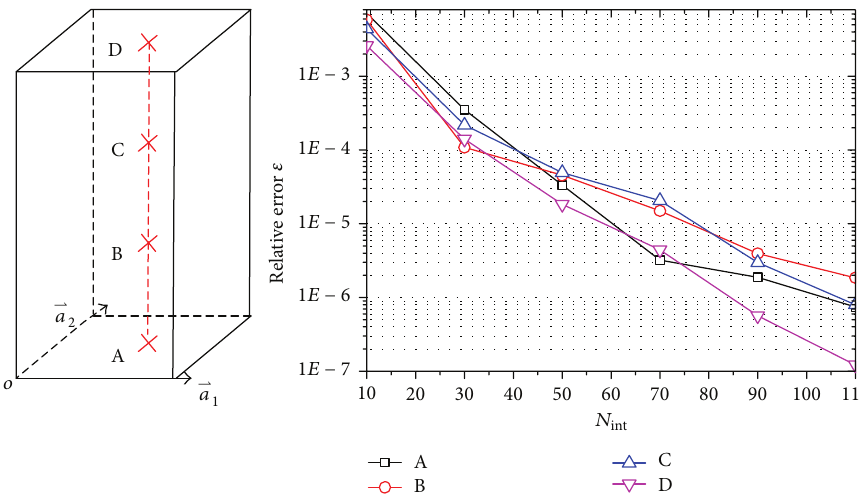
|󳨀⇀ |󳨀⇀ 𝑎 | = 𝑎 | = 0.55𝜆 , ℎ = 2 . 2 𝜆 ; phase shifts 𝑘 = 1 2 𝑥 ×𝑁 ×2𝑁 int int int equispaced